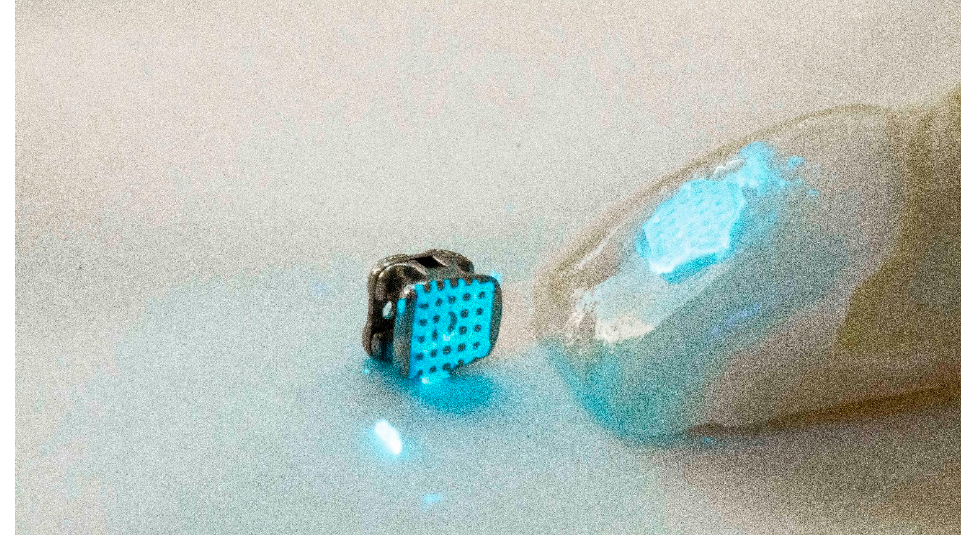
Figure 2. Bracket removal under UV light 360–370 nm 20 mW/cm 2 .